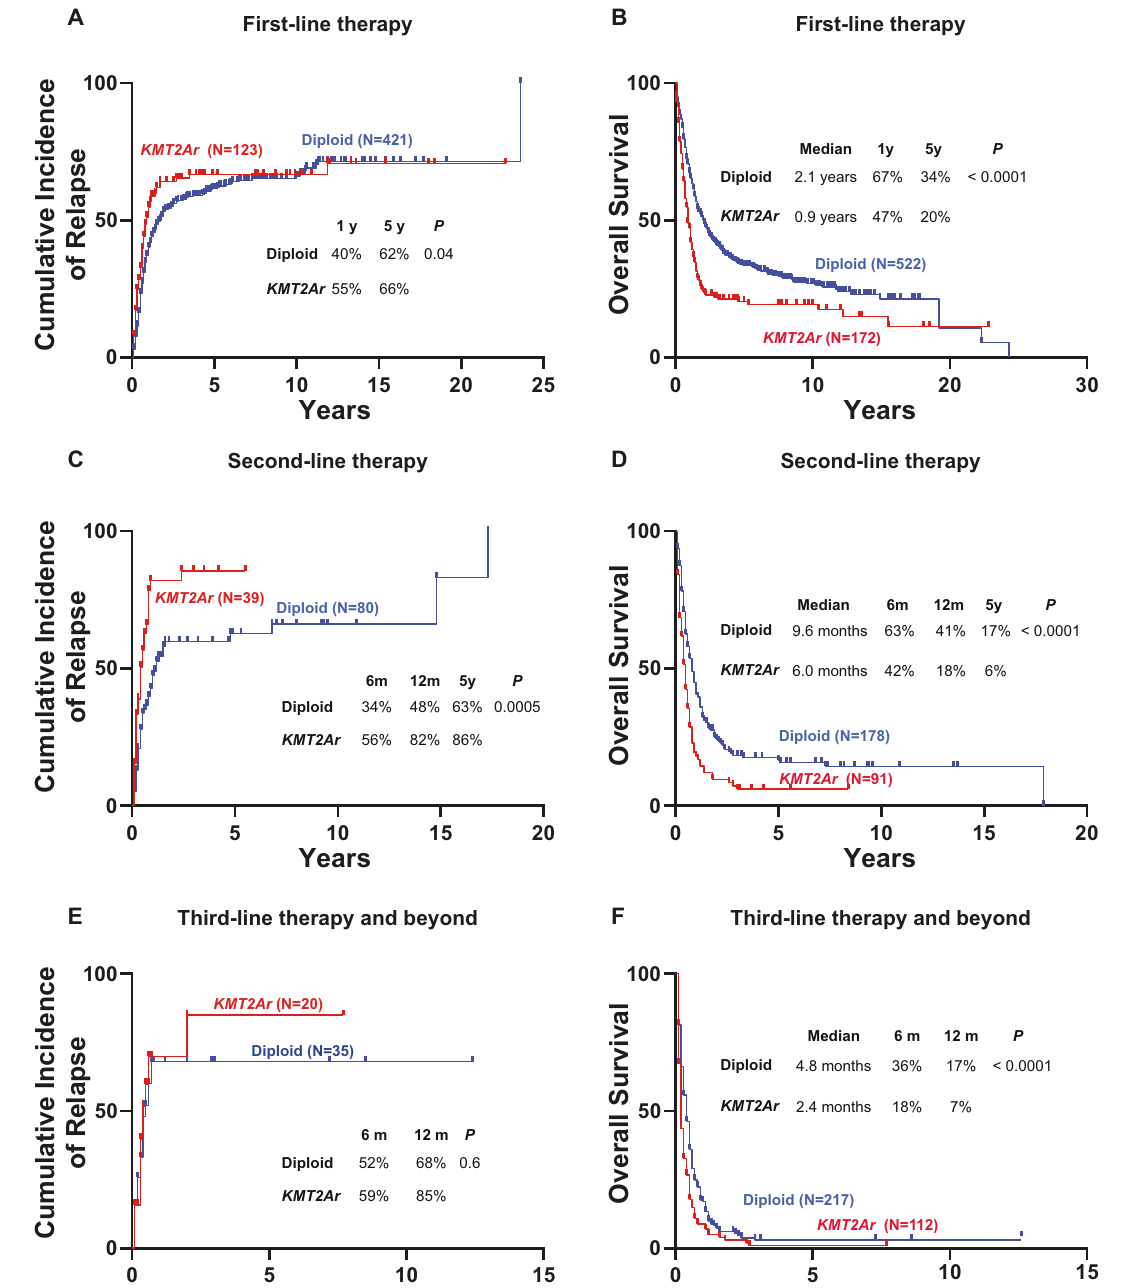
Fig. 3 Cumulative incidence of relapse and overall survival for patients with KMT2Ar AML by a line of therapy compared with an age- matched cohort of AML with diploid karyotype. A Cumulative incidence of relapse following fi rst-line therapy. B Overall survival following fi rst-line therapy. C Cumulative incidence of relapse following second-line therapy. D Overall survival following second-line therapy. E Cumulative incidence of relapse following third-line therapy. F Overall survival following third-line therapy. Treatment start date for second- line treatment and beyond was used for the calculation of